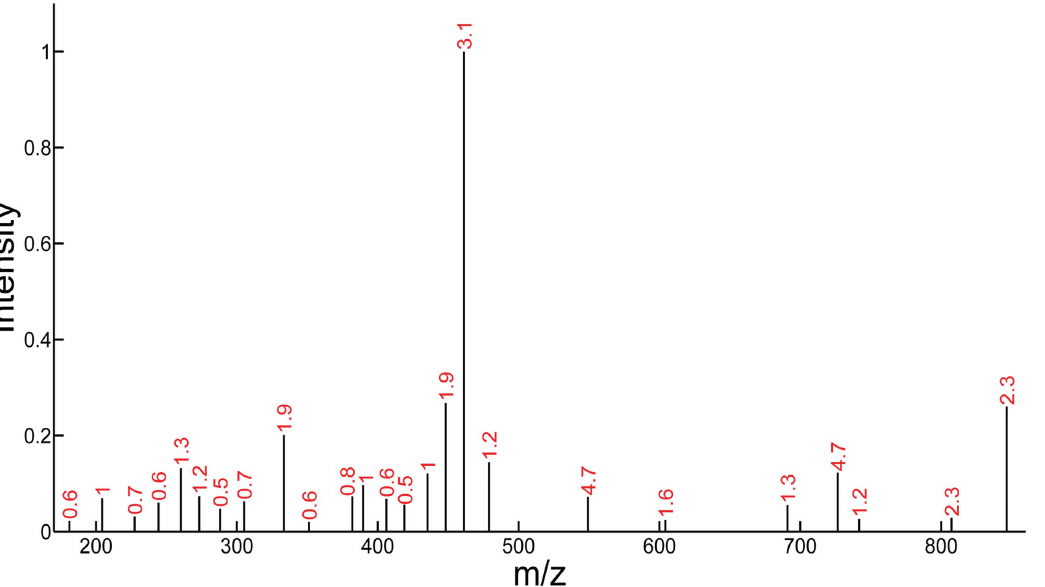
Figure 1. Peptide Matching Discriminability (PMD) for the selected peaks (black bars). The peptide matching discriminability values for peaks are marked as red numbers.